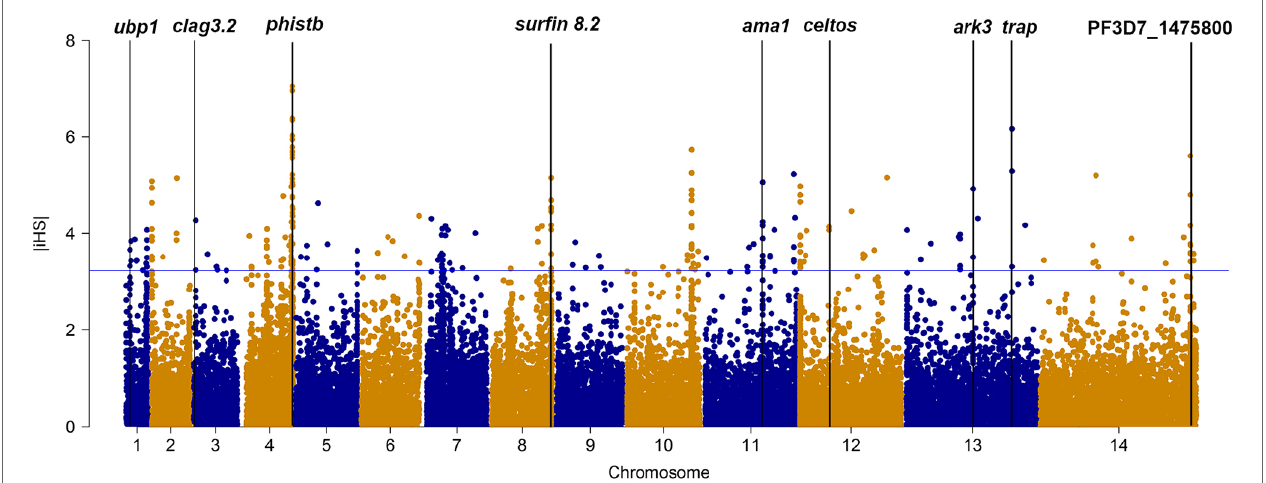
FIGURe 1 | The top |iHS| hits in isolates from China–Myanmar border. X axis is chromosomes 1 to 14 in alternating colors; y axis is the value of |iHS|. The loci above the blue horizontal lines have the top 1% of |iHS| values.